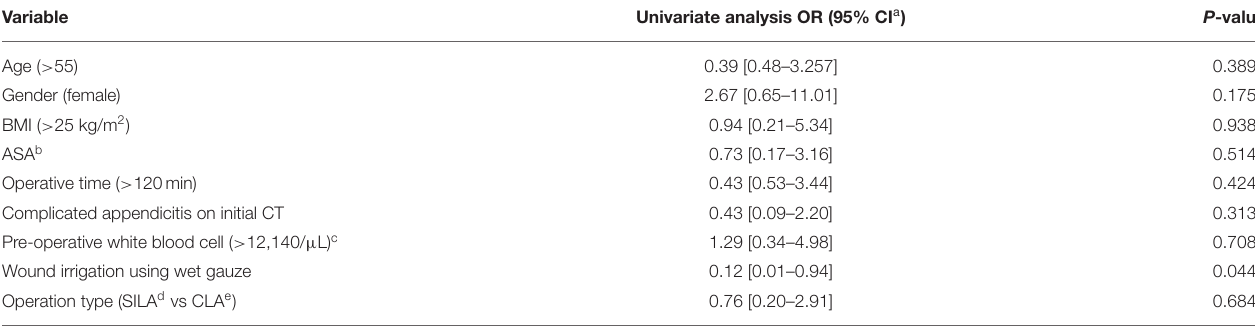
TABLE 3 | Predictors of superficial/deep SSI after laparoscopic appendectomy identified using univariable logistic regression analysis.